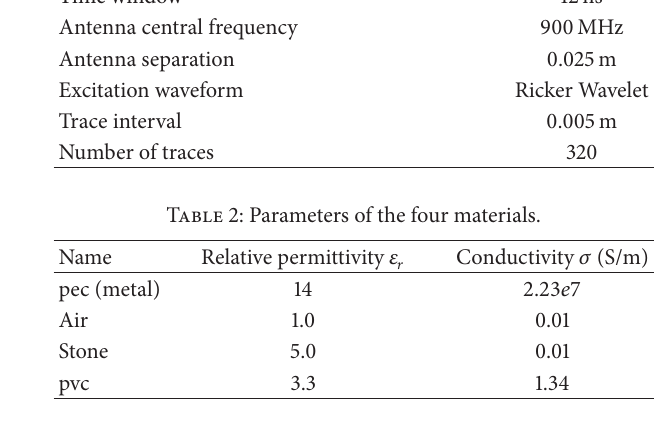
Figure 1: One of the simulation models.